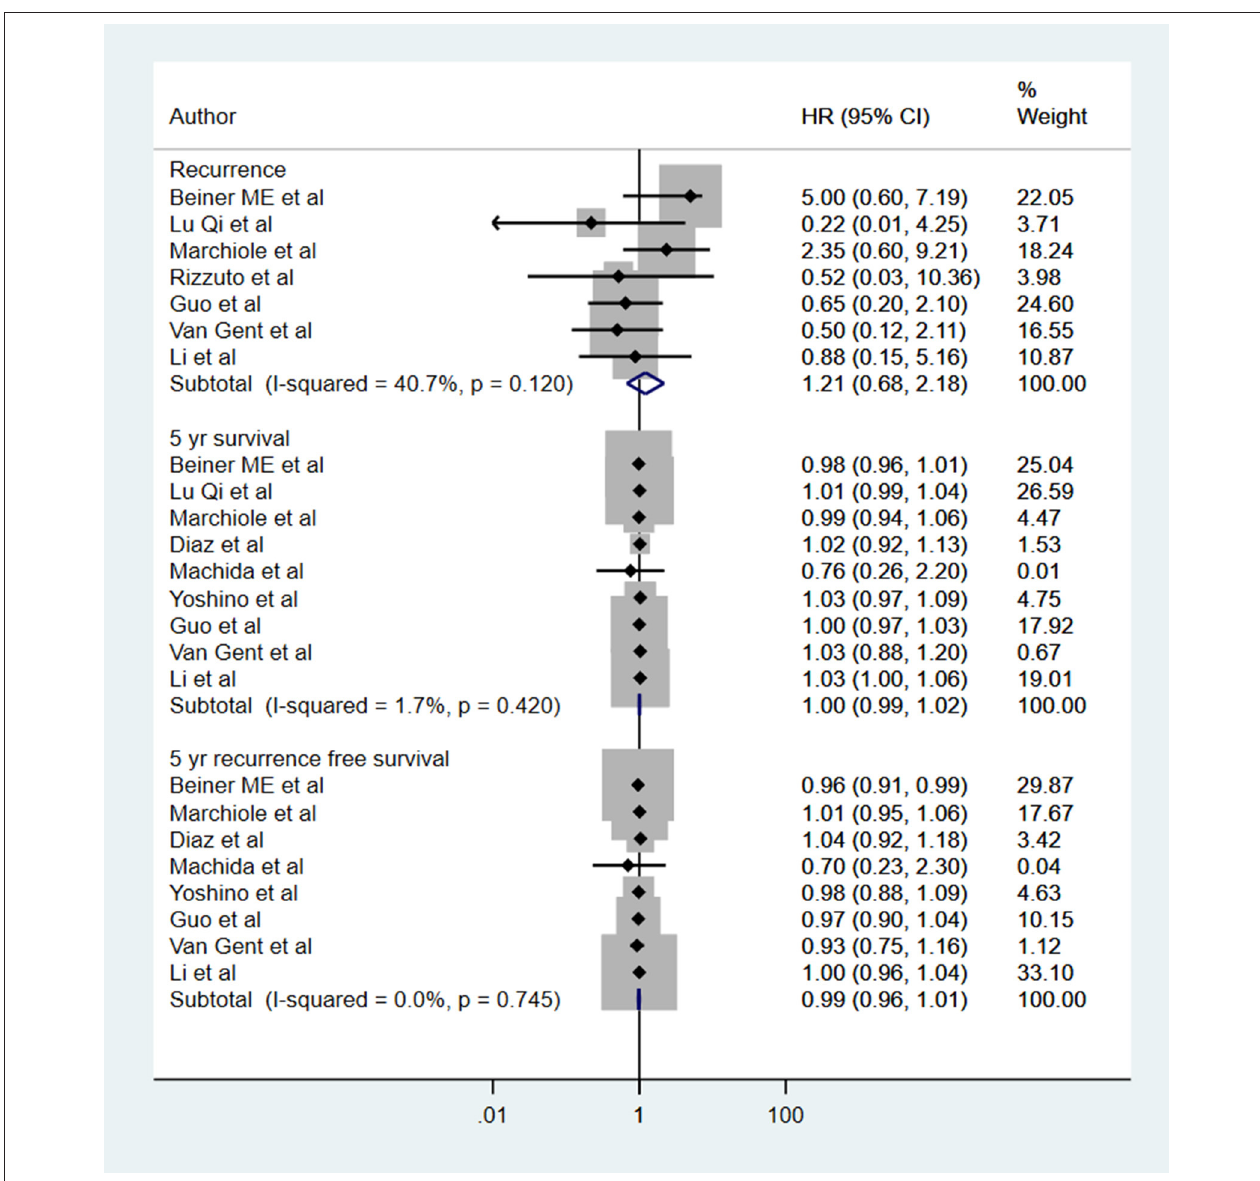
FIGURE 7 | The pooled effect size for the recurrence, 5-year overall survival, and 5 years recurrence-free survival based on comparison between radical trachelectomy and hysterectomy in patients with early-stage cervical